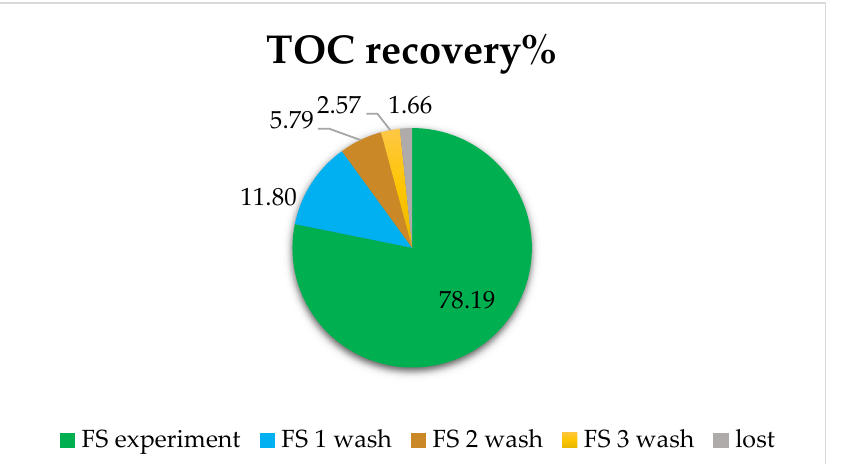
Figure 9. Total Organic Carbon (TOC) recovery in aquaporin forward osmosis membrane. FS corresponds to the %TOC after the experiment; FS wash corresponds to the %TOC after the membrane washes according to the order FS 1 wash, 2 wash, and 3 wash.